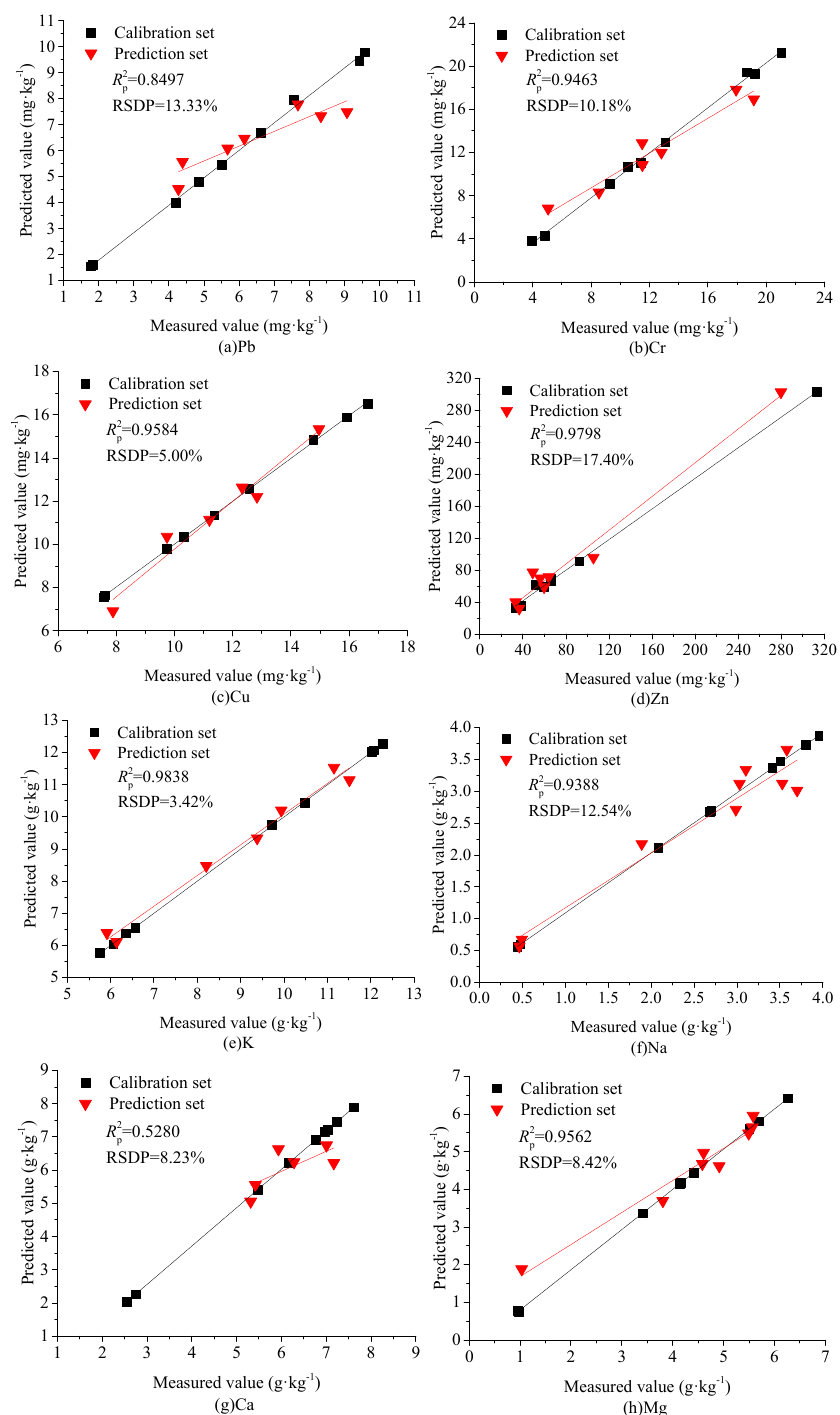
Figure 3. Prediction results of major metals in agricultural biochar using BP-Adaboost. ( a ) Pb, ( b ) Cr, ( c ) Cu, ( d ) Zn, ( e ) K, ( f ) Na, ( g ) Ca, ( h ) Mg.